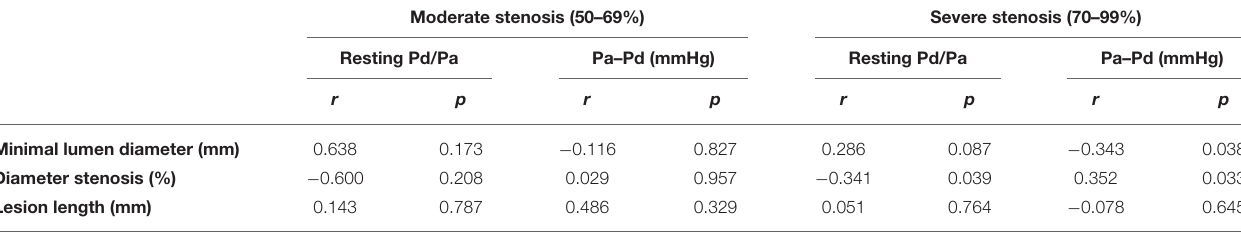
TABLE 2 | Correlation between pressure-derived and angiography-derived indices based on stenosis severity classification.